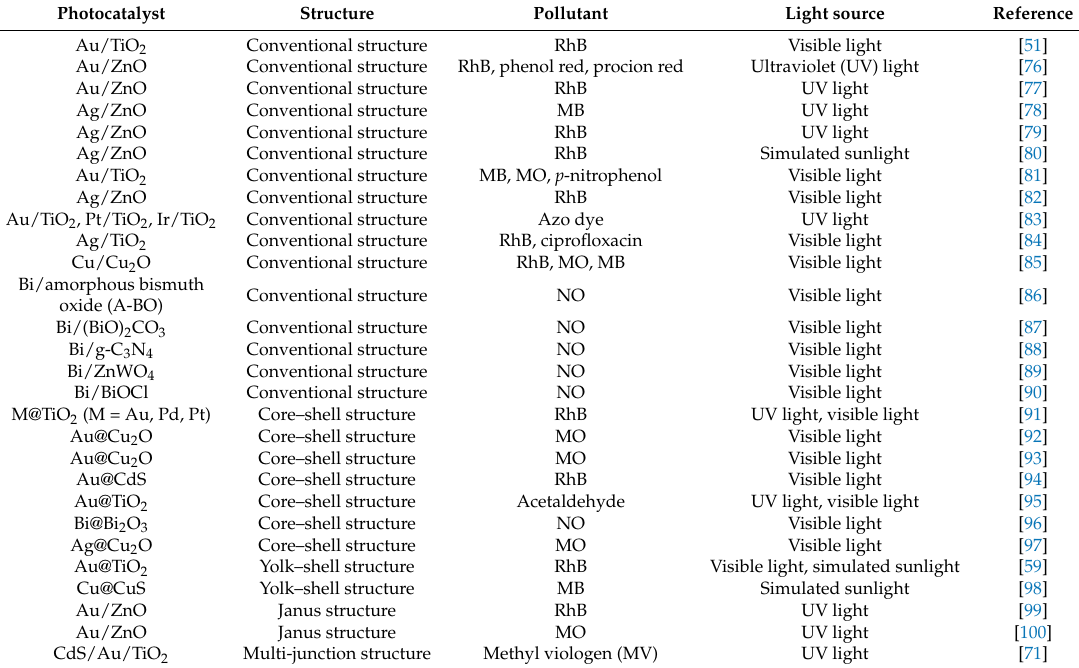
Table 1. Metal/semiconductor (M/S) nanocomposite photocatalysts for environmental